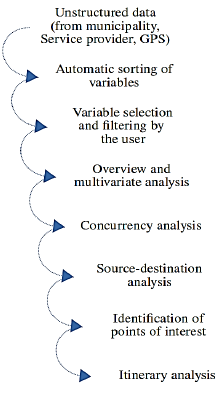
Figure 2. Analysis stages of the AVIMEU model organized by